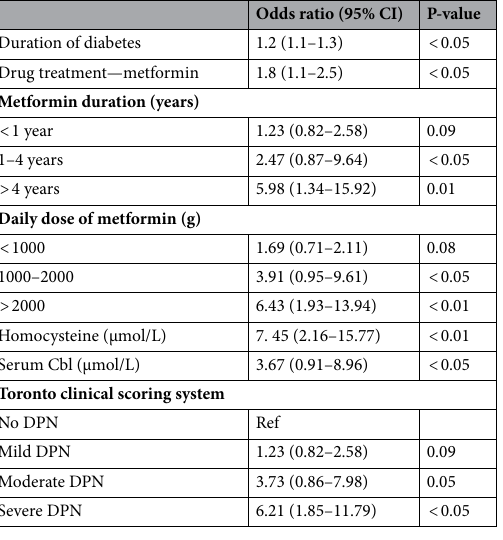
Table 4. Multivariate logistic regression analysis of independent predictors of diabetic peripheral neuropathy in metformin-treated diabetics. DPN: diabetic peripheral neuropathy, Cbl: cobalamin, DPN: diabetic peripheral